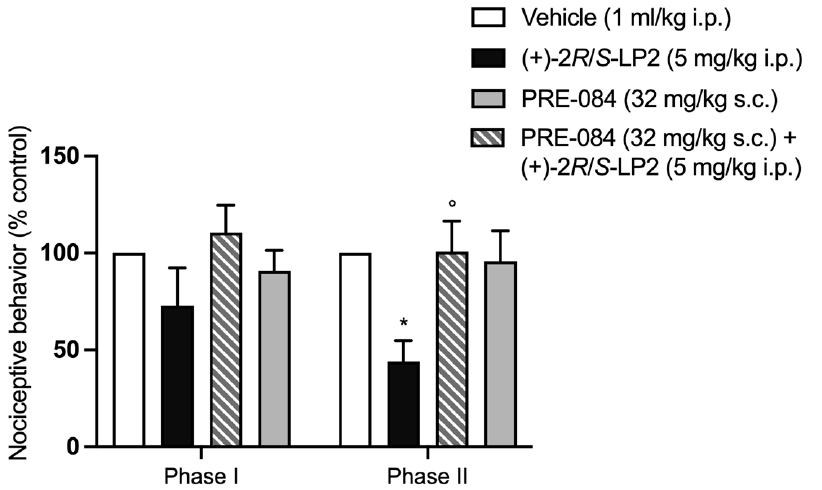
Figure 5. The antinociceptive effect of (+)-2 R / S -LP2 was antagonized by PRE-084 pre-treatment. Subcutaneous administration of PRE-084 hydrochloride (32 mg/kg) 20 min before (+)-2 R / S -LP2 reverted its effect in the second phase of the formalin test. Results are expressed as mean ± SEM ( n = 6–8 per group) and are represented as the percentage of inhibition of pain responses of the respective vehicle group (100%). ° p < 0.05 vs. (+)-2R/S-LP2, * p < 0.05 vs. Vehicle, two-way ANOVA followed by Bonferroni post-hoc